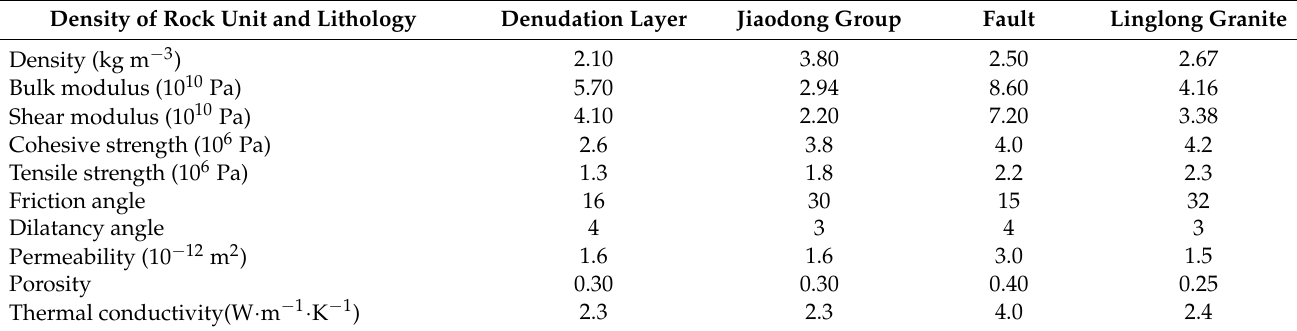
Table 2. The parameters of the numerical simulation model for the Dayingezhuang gold